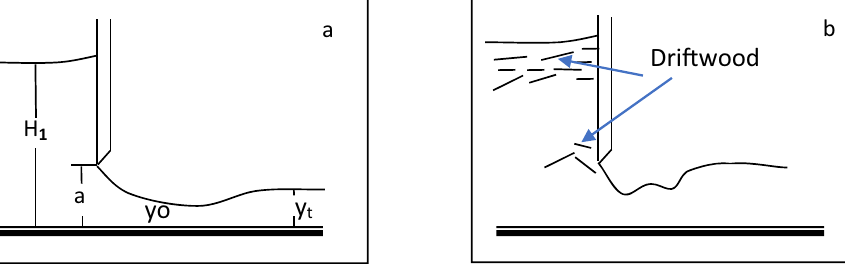
Figure 3: E ff ect of driftwood on sluice gate fl ow ( a ) without driftwood ( b ) with